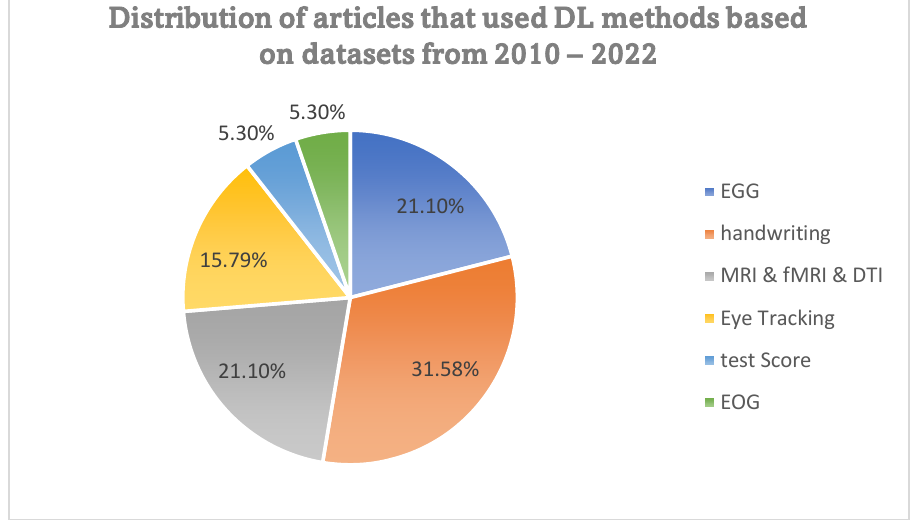
Figure 4. Distribution of articles that used DL methods based on datasets from 2010 to 2022.